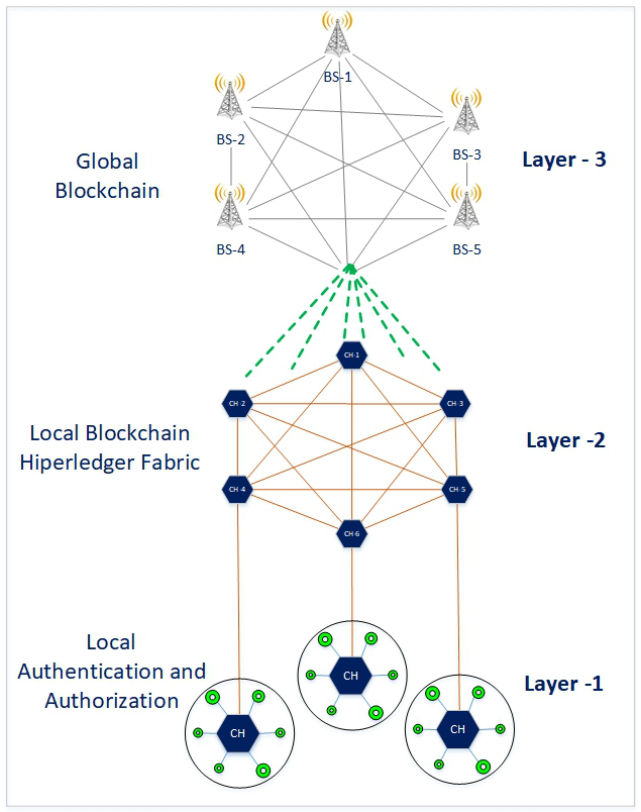
Figure 1. Multi-Layer model for Internet of Things (IoT) network.